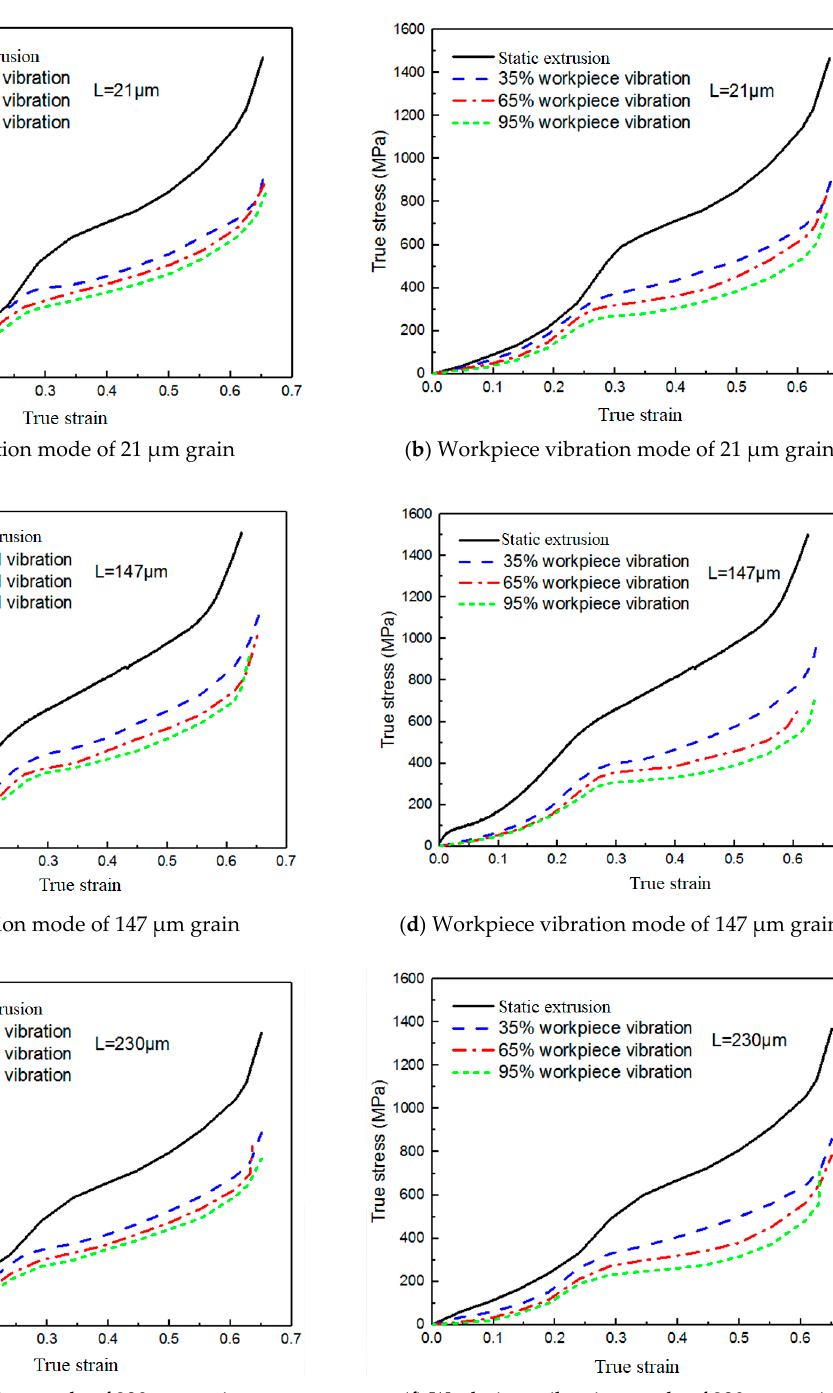
Figure 5. True stress and true strains with di ff erent ultrasonic power